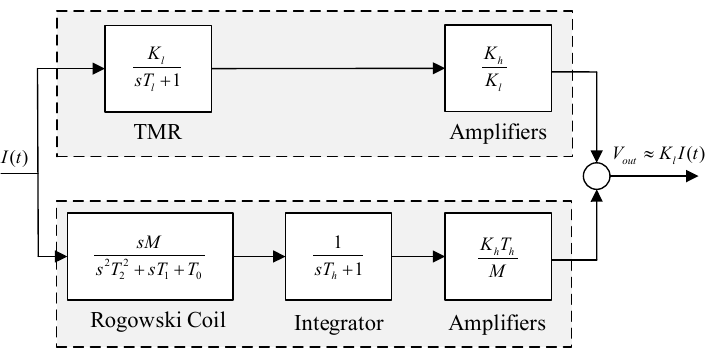
Figure 7. Principle of the composite current measurement.